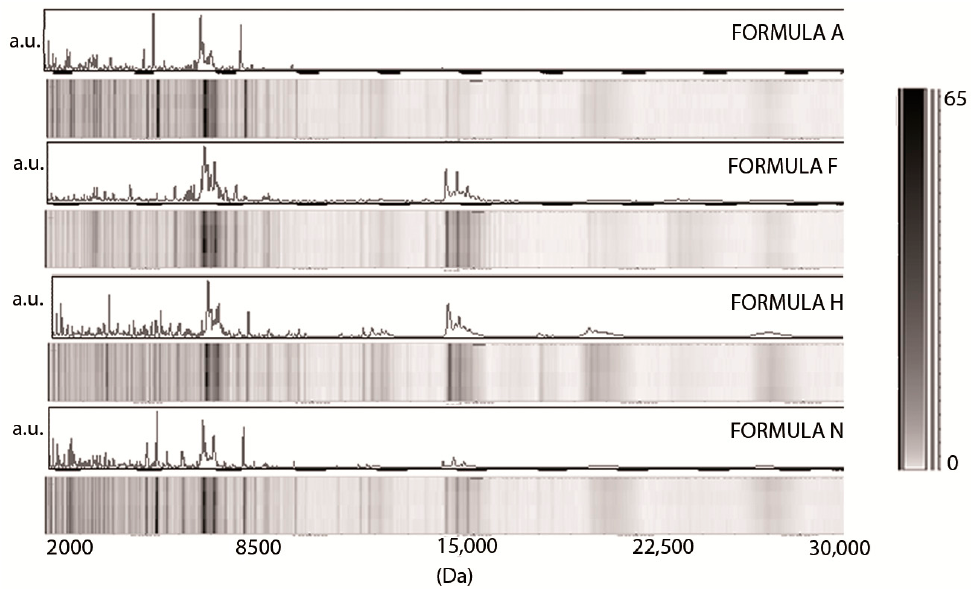
Figure 2. Representative MALDI-TOF MS profiling and pseudogel view of commercial starting formula from four different companies (Aptamil 1, A; Formulat 1 from Dicofarm, F; Humana 1, H; Nidina 1 from Nestlé, N). The mass-to-change ratios ( m / z ) are reported on the X axis (Da), while the peak intensities are indicated as arbitrary units (a.u.) in the gray scale bar on the Y axis.